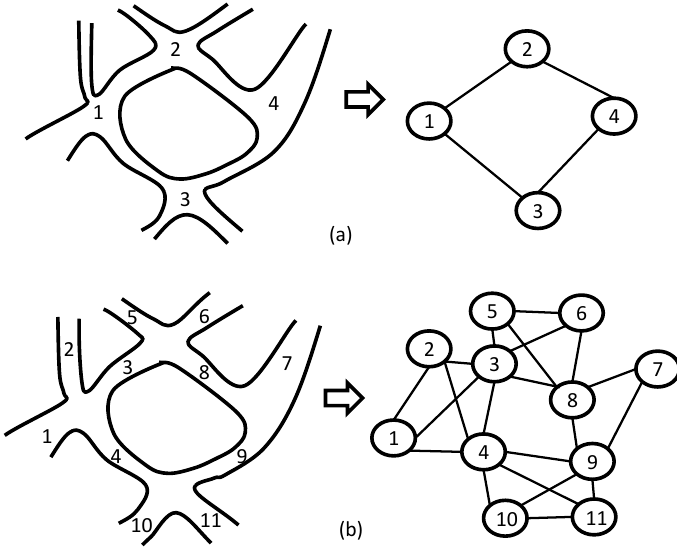
Figure 2. The two graph models are explained using two different examples. ( a ) The primal graph model, which consists of representing the intersections by nodes and the roads by edges. ( b ) The dual graph model, which consists of considering the roads as the graph nodes and the crossing point between them as